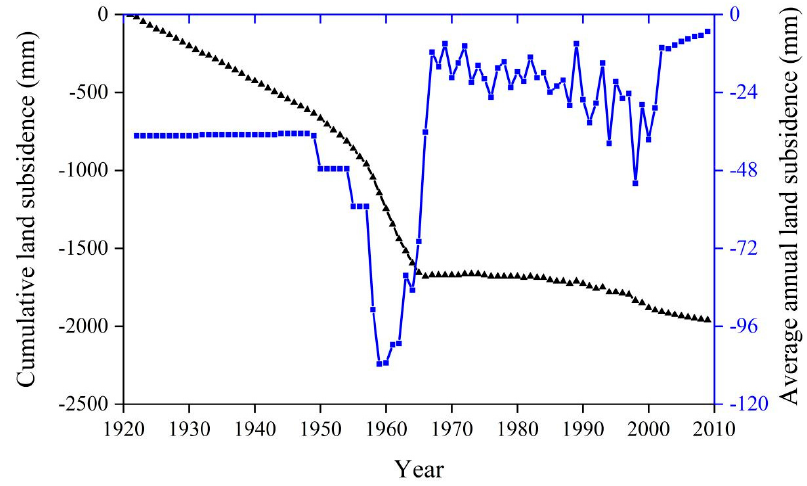
Figure 6. Changes in land subsidence in Shanghai 1920–2010.